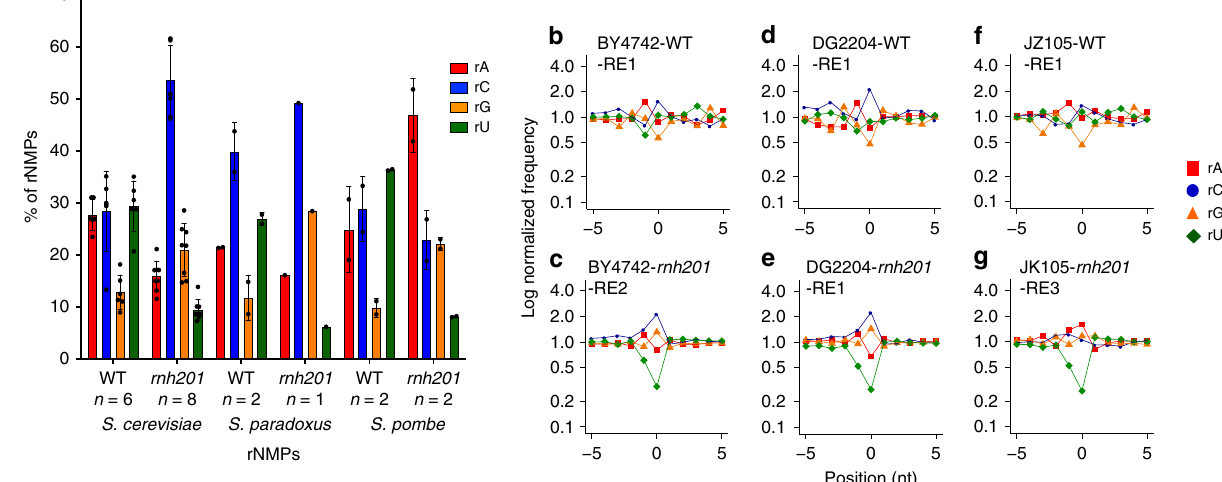
Fig. 5 Identity and frequency of rNMP types in the nuclear yeast genome. a Bar graph with corresponding data points showing percentage of rA, rC, rG, and rU found in nDNA of WT or rnh201 Δ strains of S. cerevisiae , S. paradoxus , and S. pombe . Mean, standard deviation, and number of libraries analyzed for each genotype are shown. b – g Zoomed-in plots of normalized nucleotide frequencies relative to mapped positions of sequences from nuclear ribose-seq libraries. Plots derived from example libraries are shown for S. cerevisiae b WT (BY4742-WT-RE1-FS106) and c rnh201 Δ (BY4742- rnh201 -RE2-FS138), S. paradoxus d WT (DG2204-WT-RE1-FS108) and e rnh201 Δ (DG2204- rnh201 -RE1-FS130), and S. pombe f WT (JZ105-WT-RE1-FS94) and g rnh201 Δ (JZ105- rnh201 -RE3-FS135). Position 0 on the x -axis represents the site of rNMP incorporation, − and + positions represent upstream and downstream dNMPs, respectively. The y -axis shows the frequency of each type of nucleotide present in the ribose-seq data normalized to the frequency of the corresponding nucleotide present in the reference genome of the indicted yeast species. Red square, A; blue circle, C; orange triangle, G; and green rhombus,